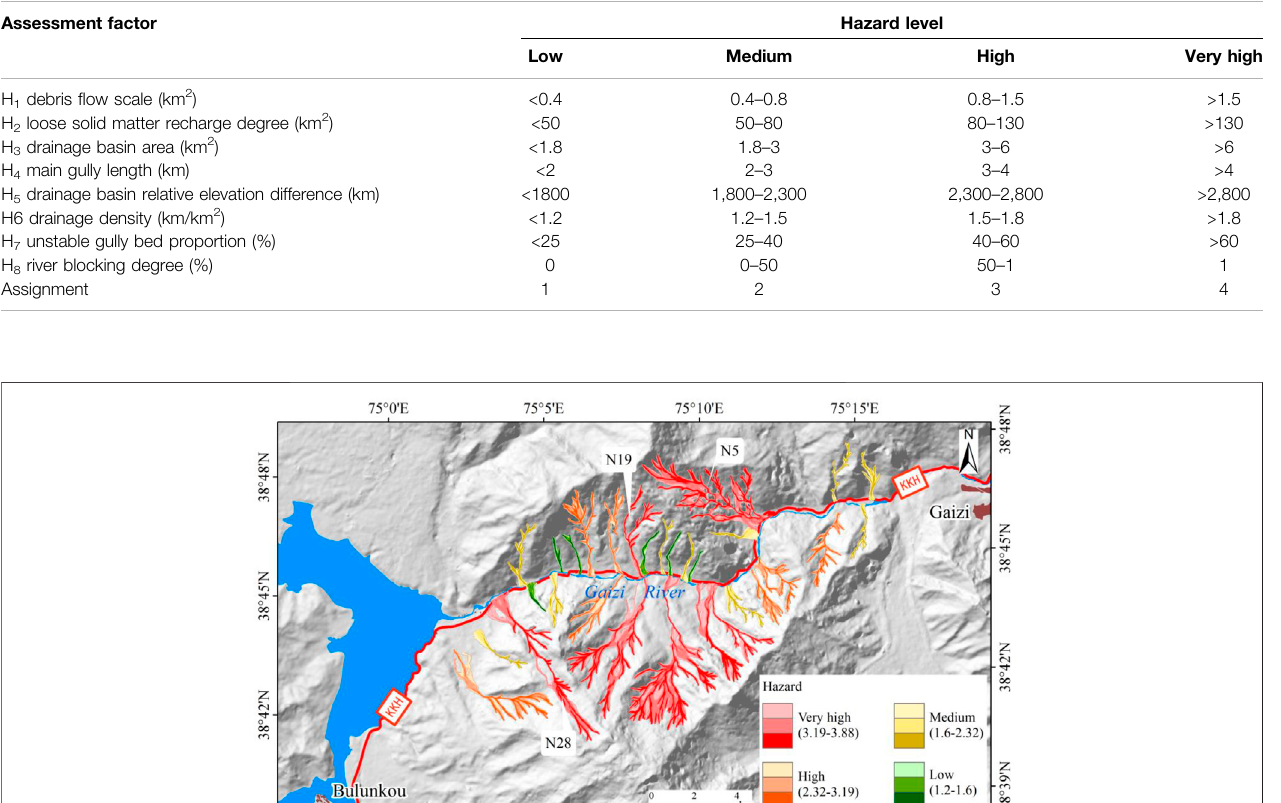
Frontiers in Earth Science |